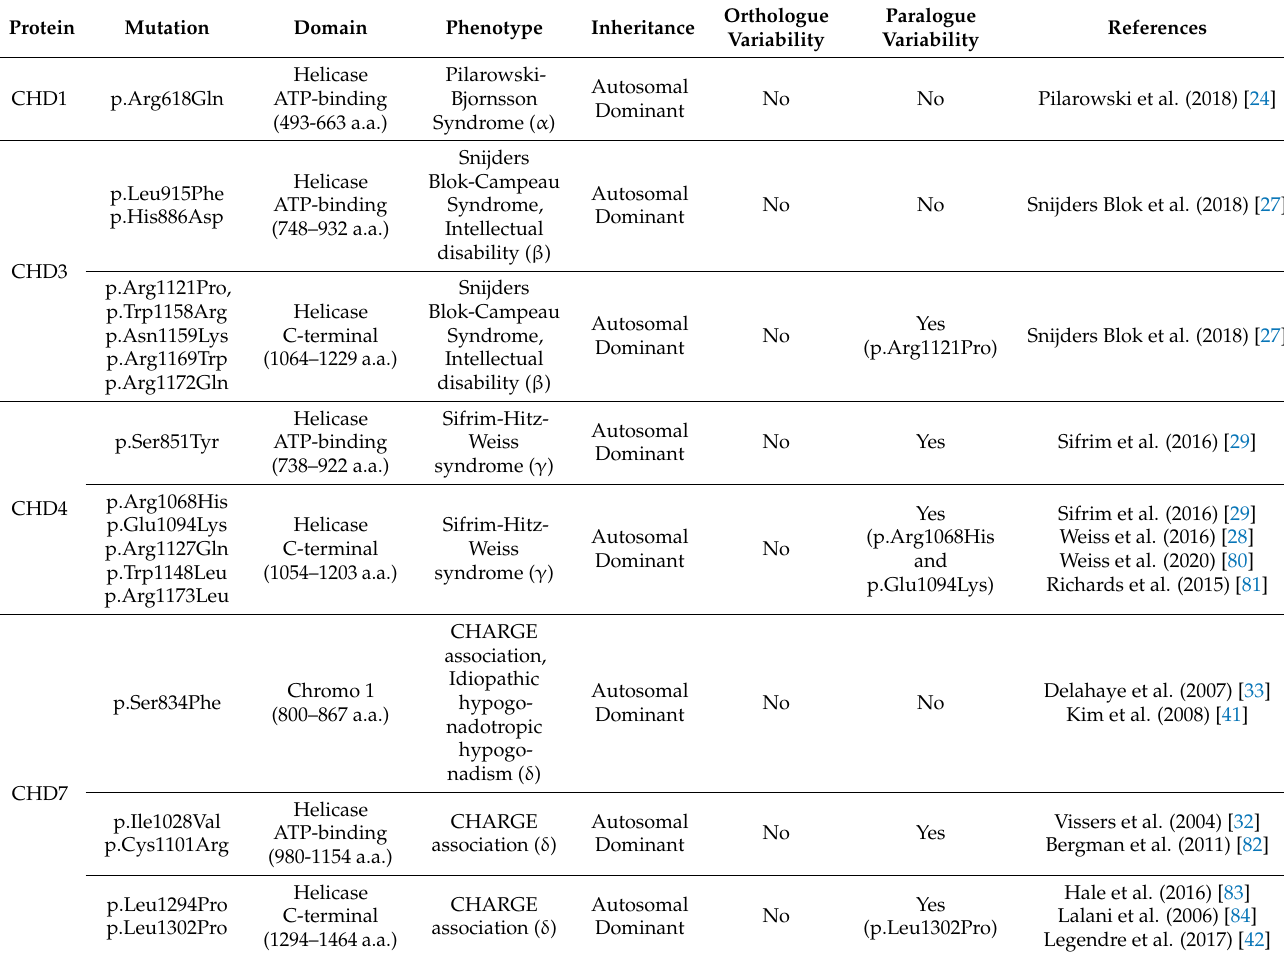
Table 1. Collection of the described human deleterious mutations (de novo) affecting conserved domains of CHD proteins. Data obtained from the ClinVar database (https://www.ncbi.nlm.nih.gov/clinvar. Accessed on 2 November 2020) [63] and also described in the